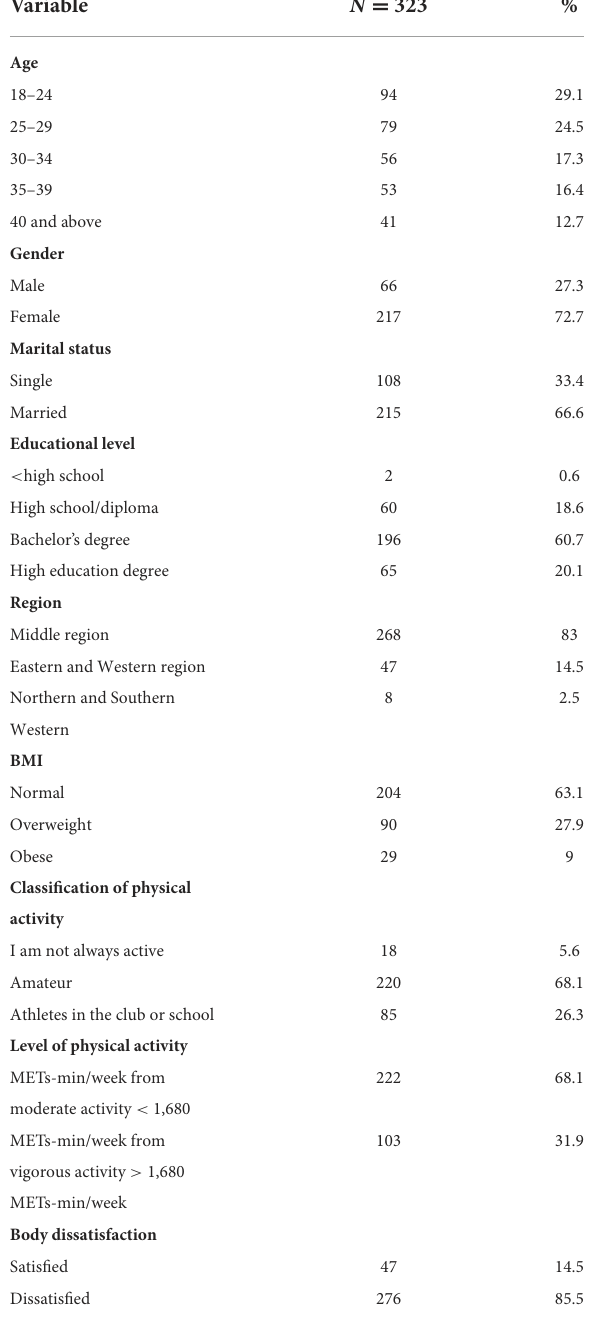
TABLE 1 Demographic characteristics of the